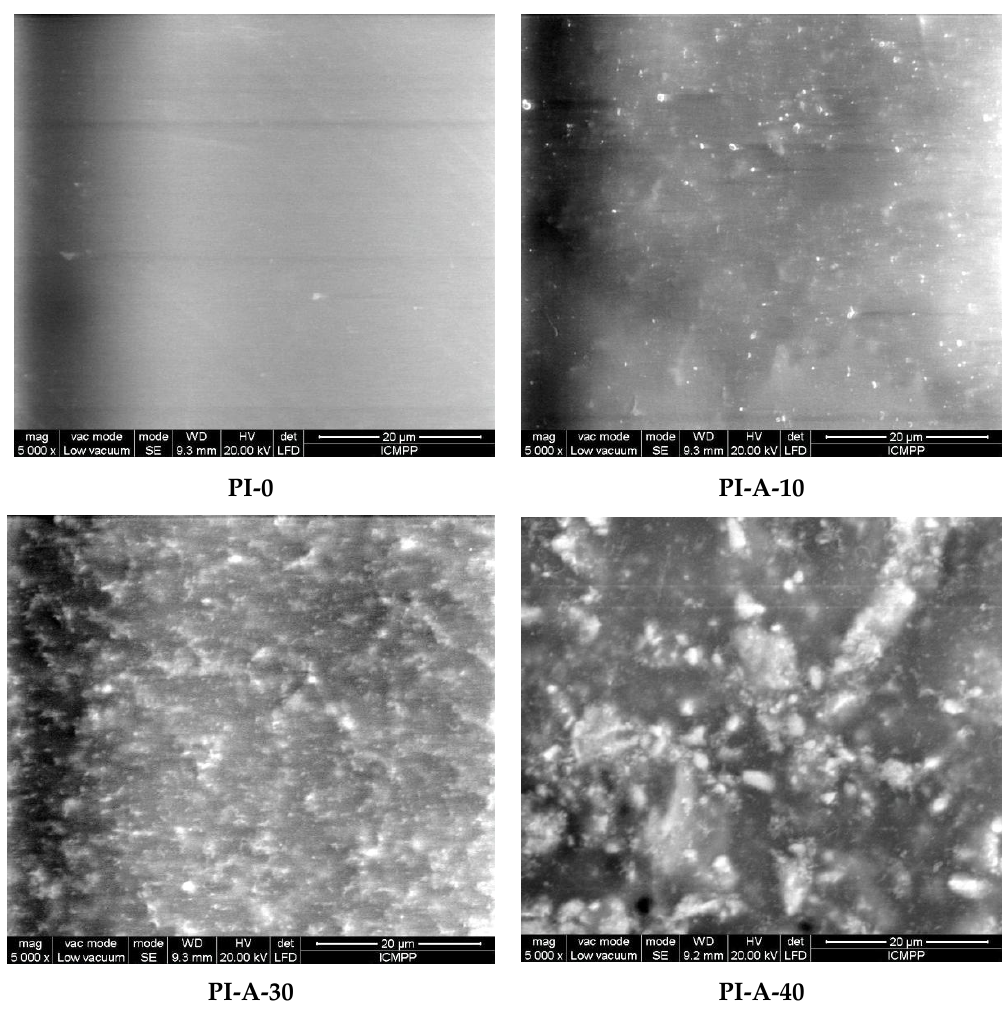
Figure 2. SEM micrographs of PI-0, PI-A-10, PI-A-30, and PI-A-40.